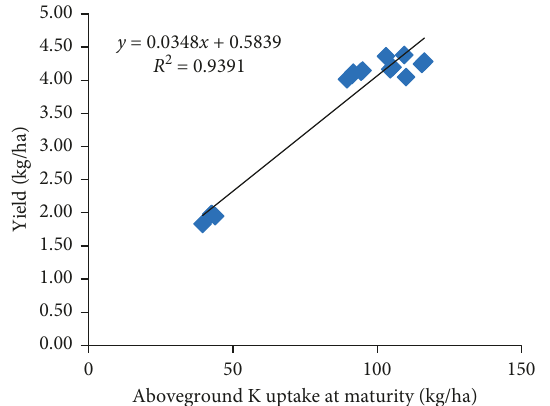
Figure 4: Relationship between the grain yields and total aboveground K at maturity across all